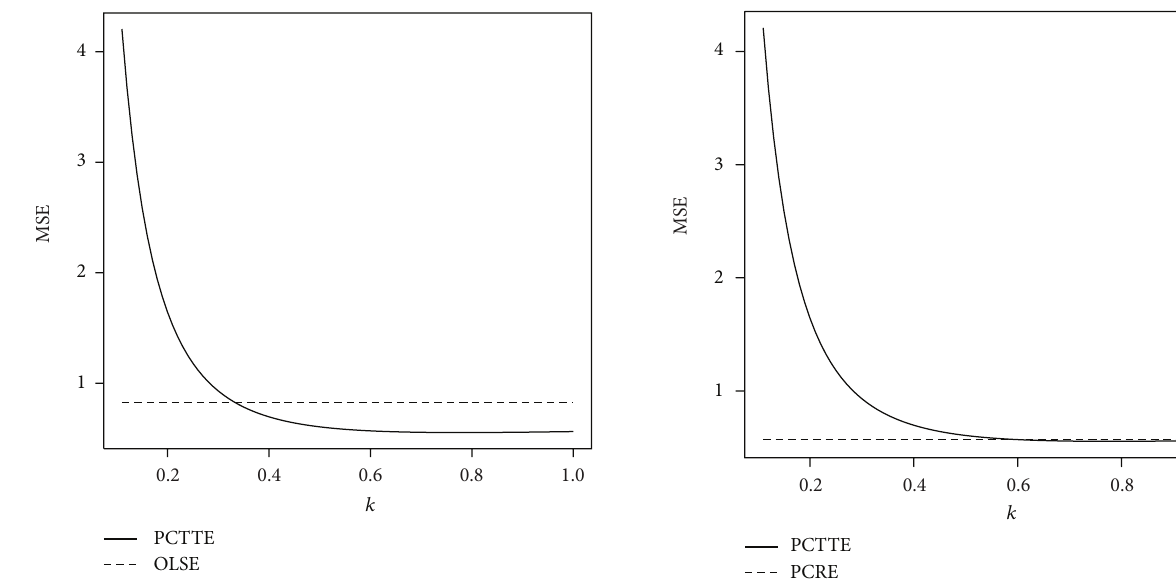
Figure 3: The MSE values of PCRE and PCTTE when 𝑑 = 0.6 .